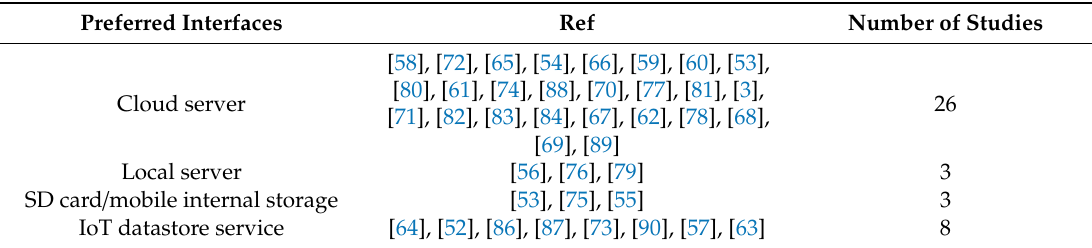
Table 6. Preferred data storage.